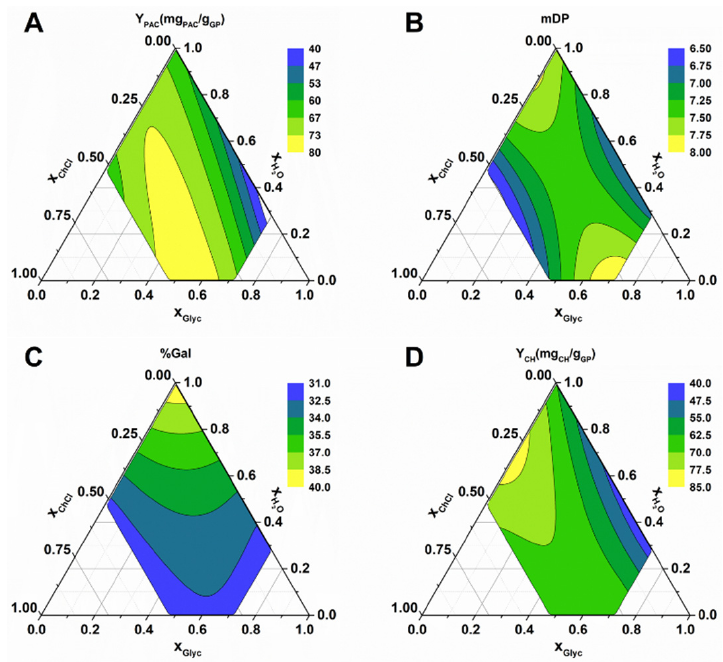
Figure 5. Contour plots obtained for solvent composition optimization of ChCl:Glyc. ( A ) Y PAC ; ( B ) ( B ) mDP; ( C ) %Gal; ( D ) Y CH mDP; ( C ) %Gal; ( D ) Y CH .